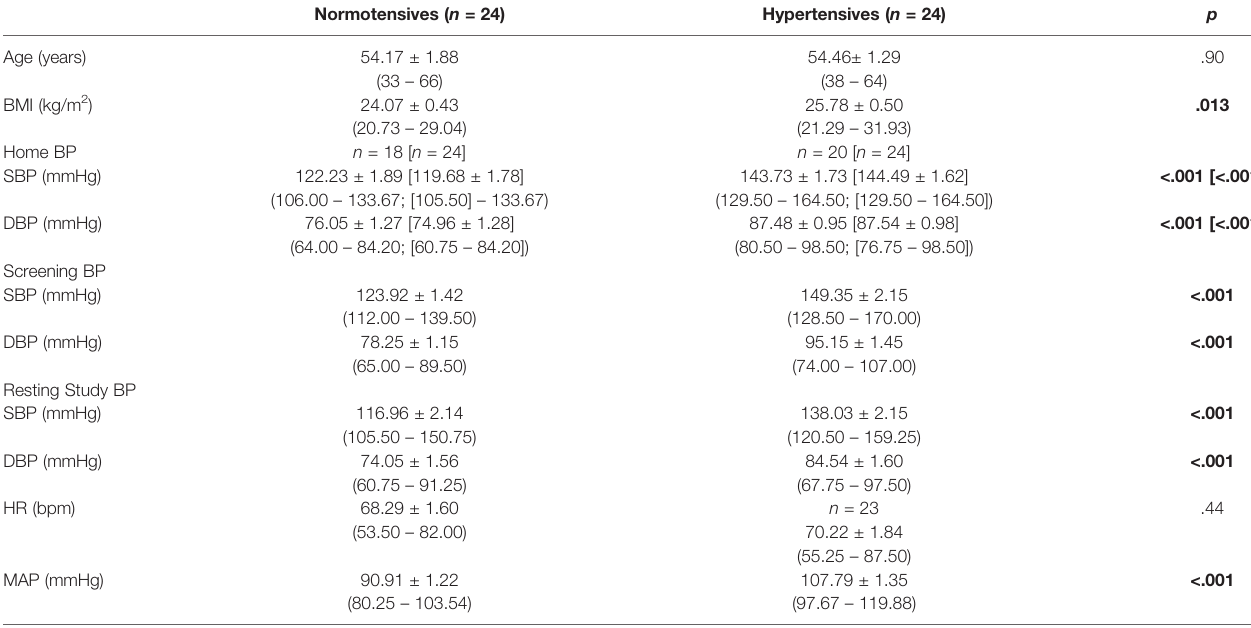
TABLE 1 | Participants ’ characteristics.